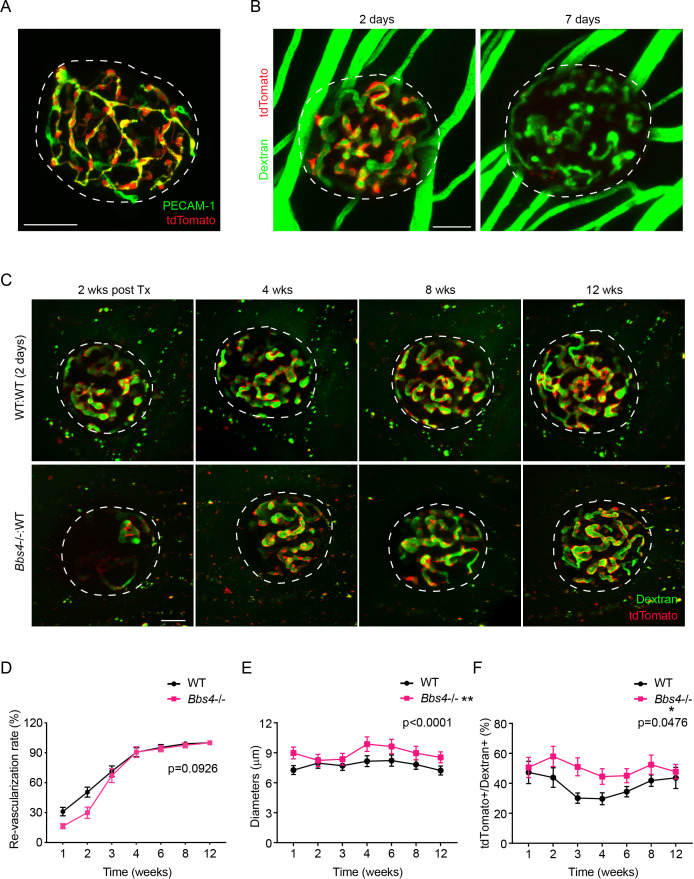
Bbs4-/- endothelial cells are less responsive to the angiogenic signals during islet re-vascularization.(A) Immuno-fluorescence staining of a freshly isolated islet from Cdh-tdT mice showing that tdTomato fluorescence (red) and intra-islet capillaries (PECAM-1, green) overlaps. (B) Representative images showing that 2-day and 7-day cultivation of Cdh-tdT islets leads to different amounts of donor endothelial cells constituting islet vasculature after engraftment. (C) Re-vascularization of 2-day-cultivated wt (upper) and Bbs4-/- (lower) islets in Cdh-tdT recipient eyes at 2-, 4-, 8- and 12-weeks post-transplantation, visualized by intravenous injection of FITC-conjugated dextran. (D) Quantification of re-vascularization rates of wt and Bbs4-/- islet grafts in Cdh-tdT recipients. (E) Average diameters of newly formed capillaries in wt and Bbs4-/- islet grafts in wt recipients. (F) Proportion of recipient to donor endothelial cells in wt and Bbs4-/- islet grafts indicated by the surface area ratio of tdTomato labeled cells to total dextran labeled islet vessels during engraftment. Results are mean ± S.E.M. *p<0.05, **p<0.01 by two-way ANOVA, n = 5 for animals and n = 2–4 islets per animal. Scale bars: 50 μm.